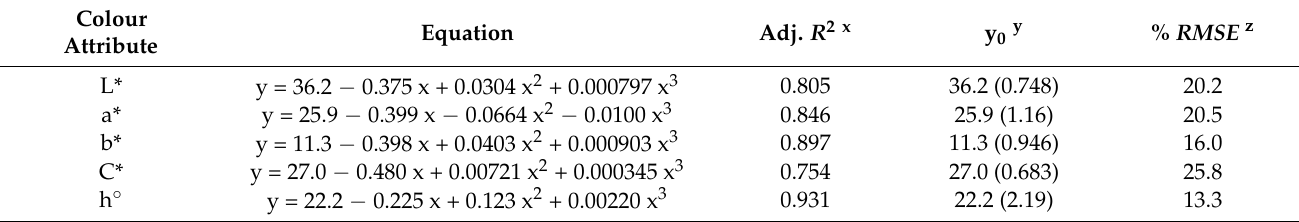
Table 3. Cubic regressions models for skin colour attributes (y) against time in days from harvest (x) in ‘Majestic Pearl’ nectarine fruit.